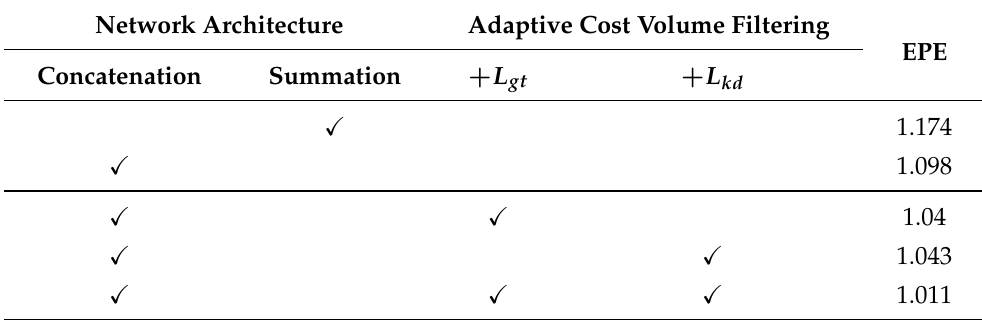
Table 4. Ablation study results of the network architecture and the adaptive cost-volume-filtering loss on the Scene Flow test